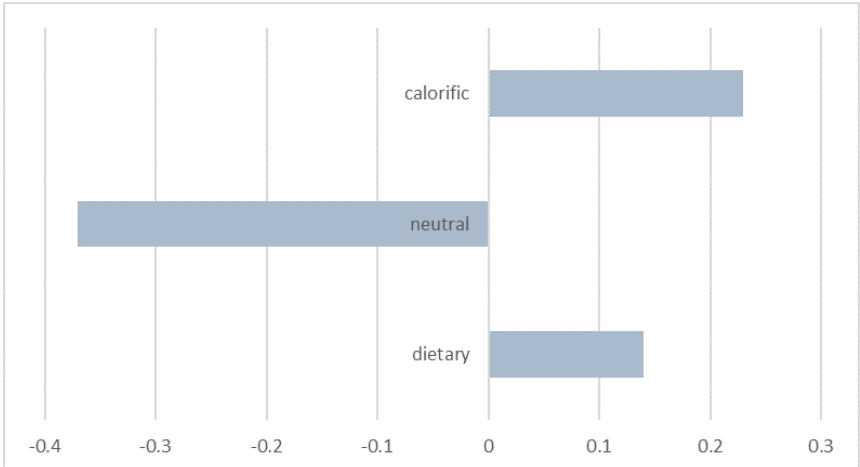
Figure 2. The role of priming on pro-healthy food choice among obese elderly.